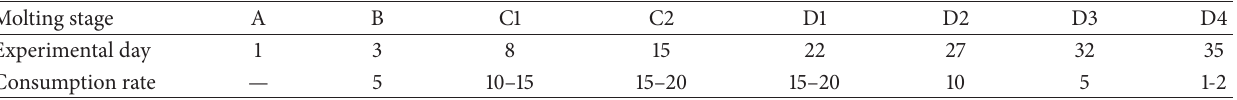
Table 3: Experimental periods and fresh feed consumption rate (% of total weight) of adult P. pelagicus at various stages during a molting period; early postmolt (A), postmolt (B), intermolt (C1), late intermolt (C2), early premolt (D1), mid premolt (D2), late premolt (D3), and very late premolt